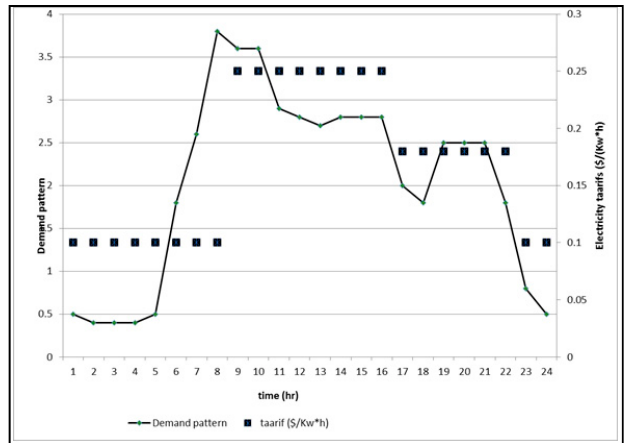
Figure 6. Demand pattern and electricity tariffs for net 1-c.